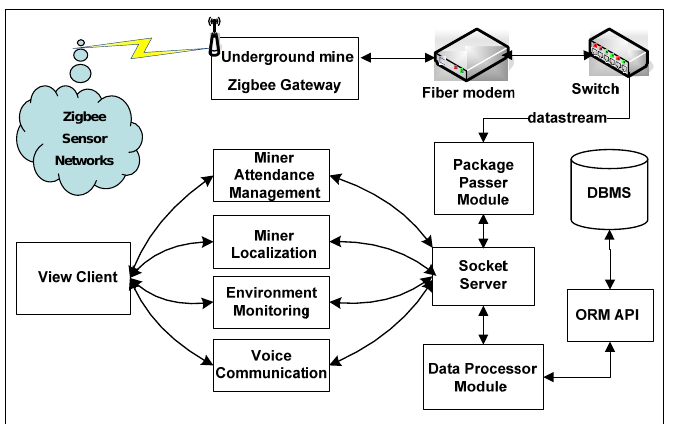
Figure 5. Distributed system architecture for